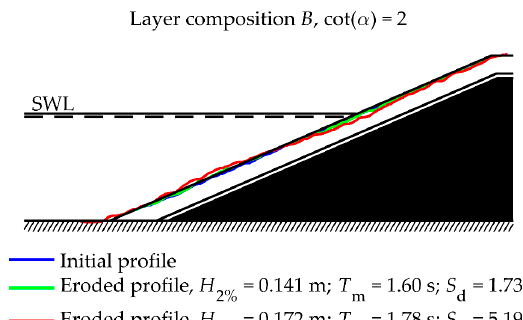
Figure 8. Example of averaged measured profiles showing the damage development in two consecutive tests.